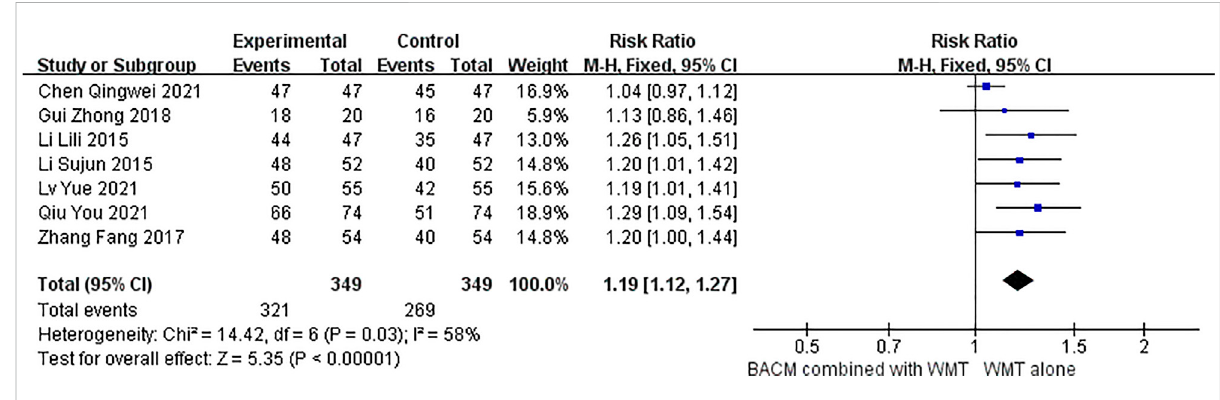
FIGURE 4 The forest plot demonstrating the clinical ef fi cacy of BACM for ICH.